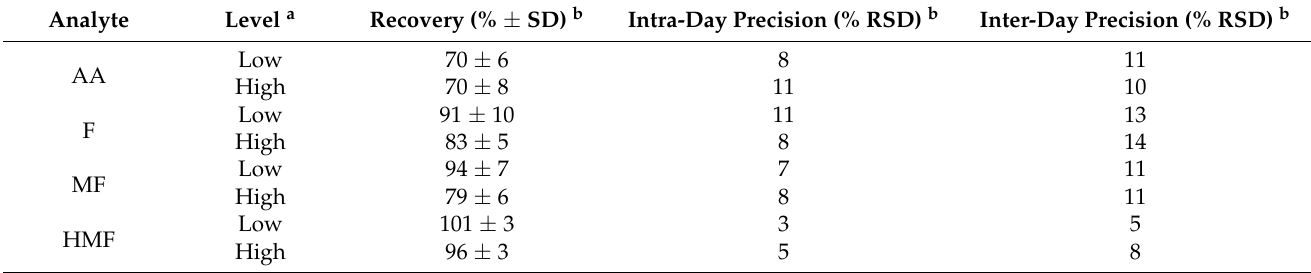
Table 4. Precision and accuracy of the proposed method at two concentration levels a